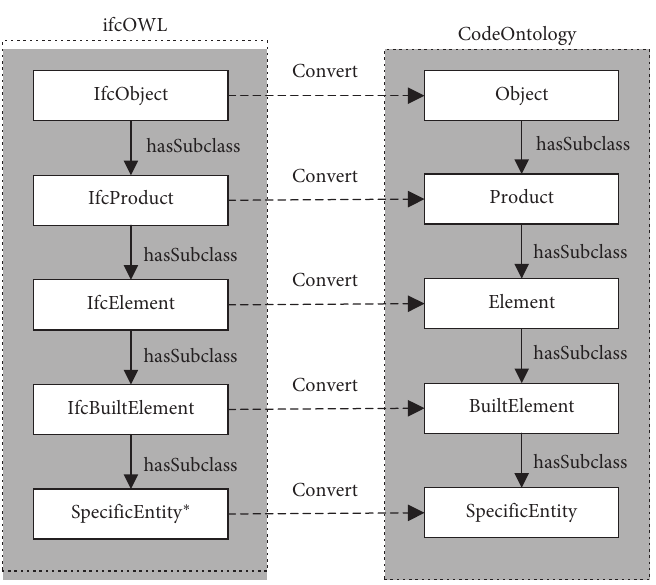
Figure 5: The property extension